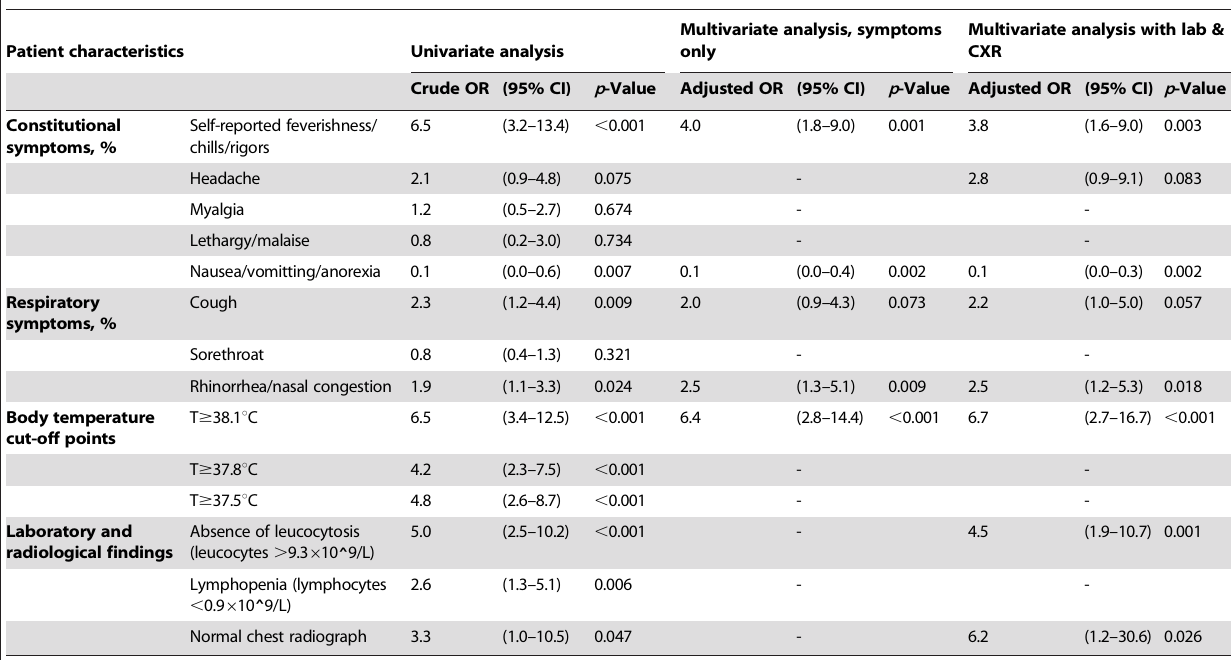
Table 3. Univariate and multivariate analyses comparing H1N1(2009) and ARI patients.